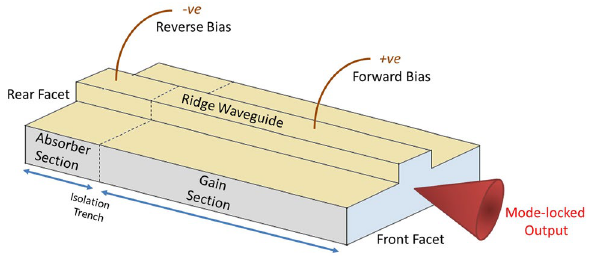
Figure 1. Typical 2-section MLLD, featuring a ridge waveguide, and two electronically isolated sections; the saturable absorber section and the gain